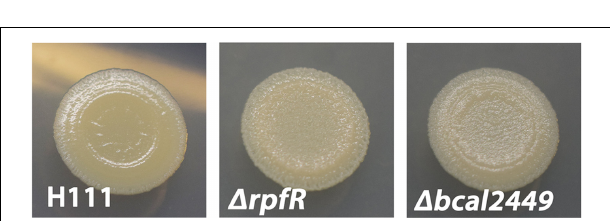
FIGURE 4 | Macrocolony formation of the B. cenocepacia wild type, and rpfR and bcal2449 mutants on solid agar. B. cenocepacia H111 and mutant derivatives were grown on ABnoNaCl agar supplemented with 1% glucose and incubated 5 days, after which images were